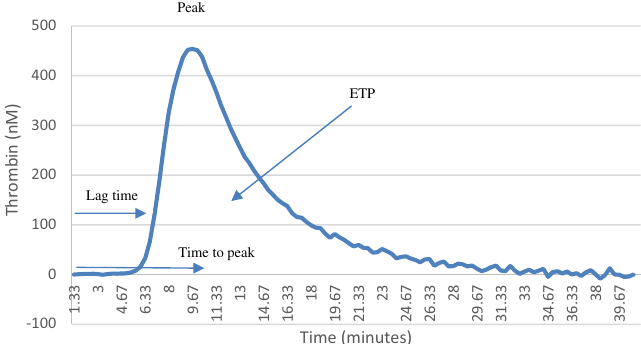
Figure 1. Calibrated Automated Thrombogram output in suspected